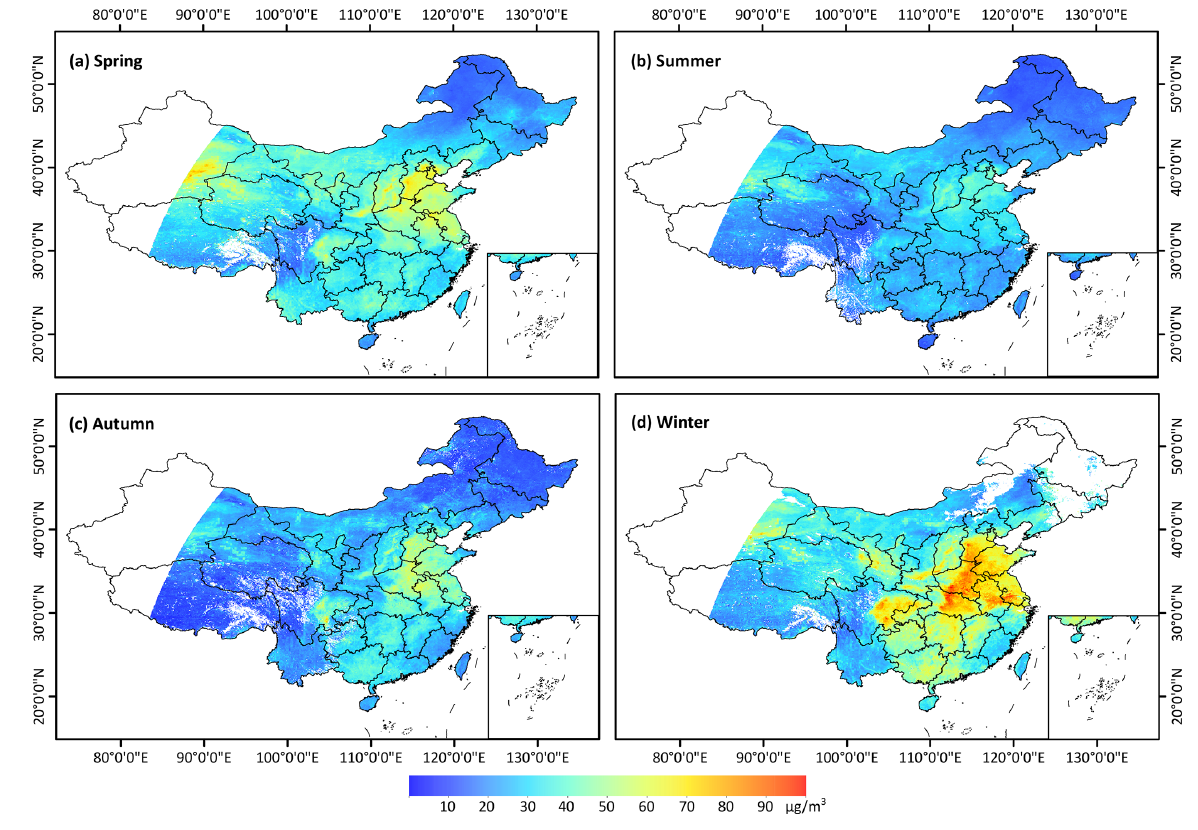
Figure 14. Himawari-8-derived seasonal mean PM 2 . 5 maps (5km) for (a) spring, (b) summer, (c) autumn, and (d) winter of 2018 across China. Table 3. Annual and seasonal mean PM 2 . 5 concentrations (µgm − 3 ) in 2018 in China, eastern China (ECHN), the Beijing–Tianjin–Hebei (BTH) region, the Yangtze River Delta (YRD), and the Pearl River Delta (PRD). Time China ECHN BTH YRD PRD Spring 32.84 ± 11.49 34.93 ± 10.95 45.75 ± 12.96 Summer Autumn 23.76 ±